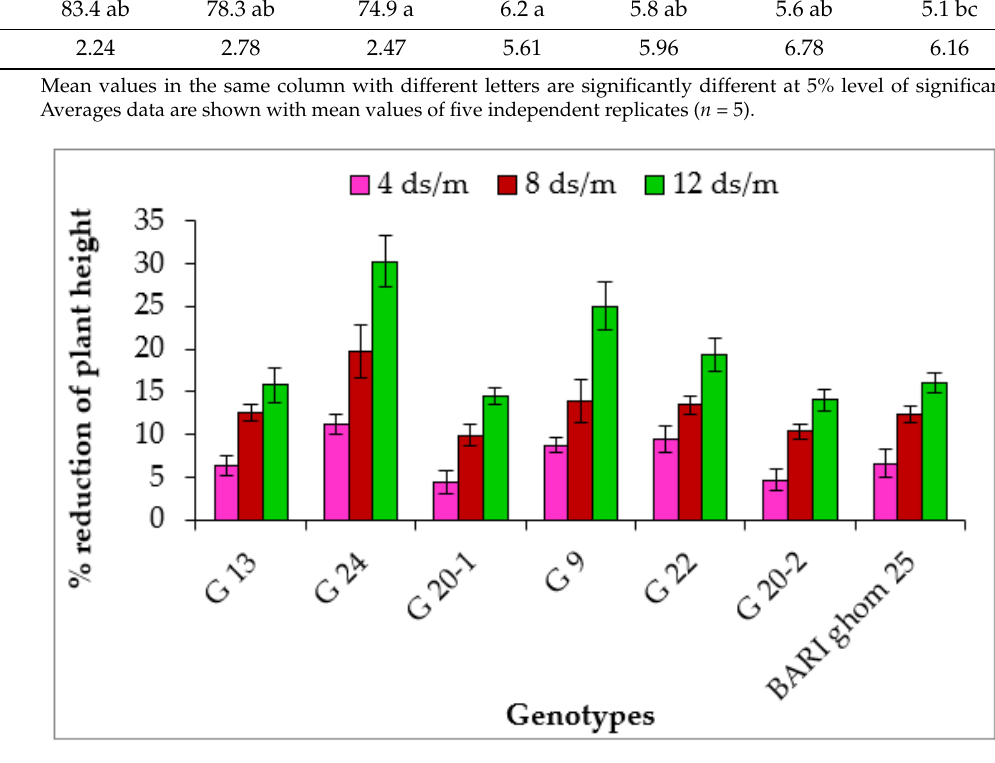
Table 1. Plant height and total tillers of wheat genotypes under different salinity levels.